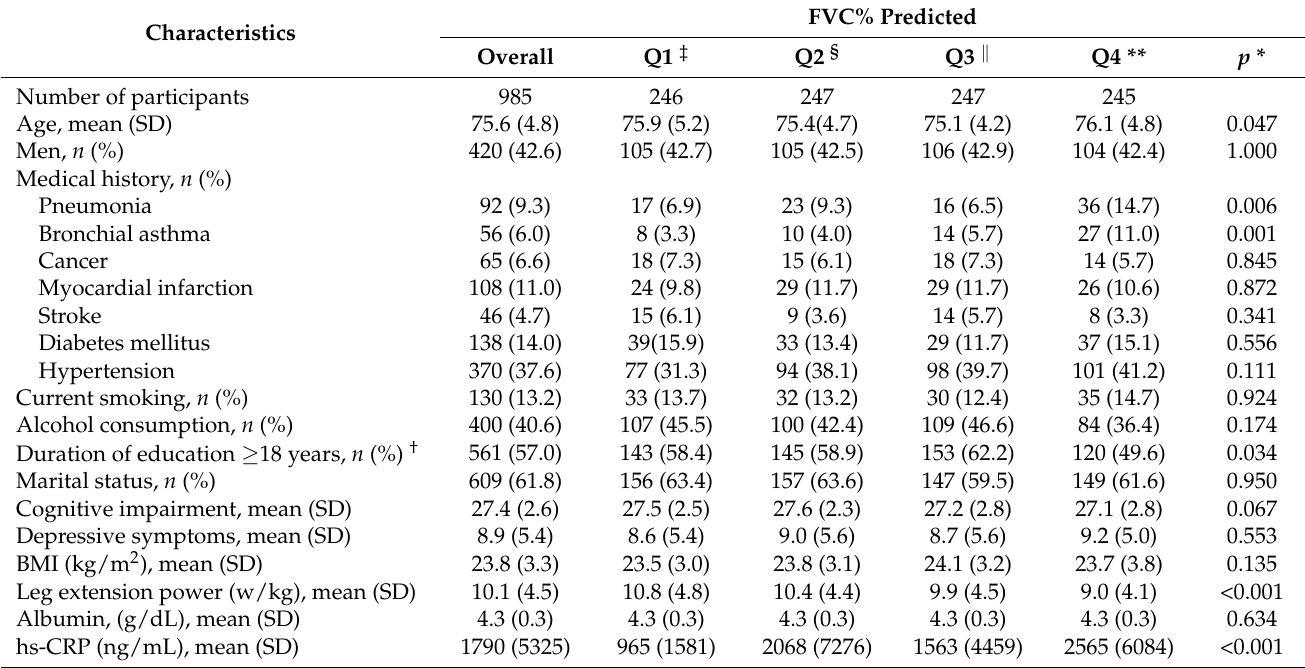
Figure 1. Inclusion and exclusion of the study participants. MMSE = Mini-Mental State Examination, hs-CRP = high-sensitive C-reactive protein. Table 1. Baseline characteristics of the study participants according to FVC% predicted ( n =